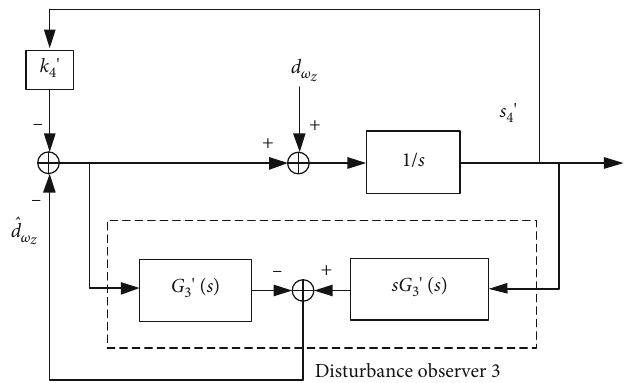
Figure 4: Disturbance observer for estimating d